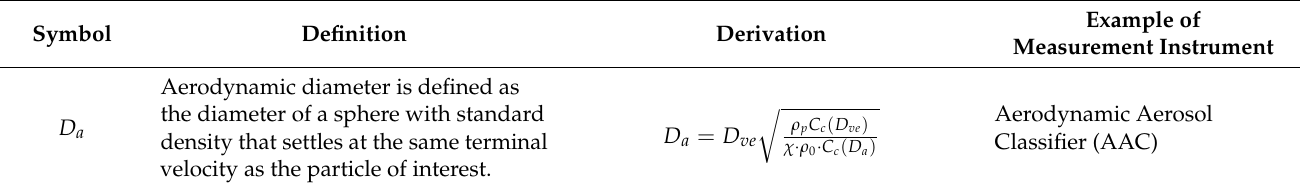
Table A1. Introductions of the diameters used in this paper. Symbol Definition Aerodynamic diameter is defined as the diameter of a sphere with standard D a density that settles at the same terminal velocity as the particle of